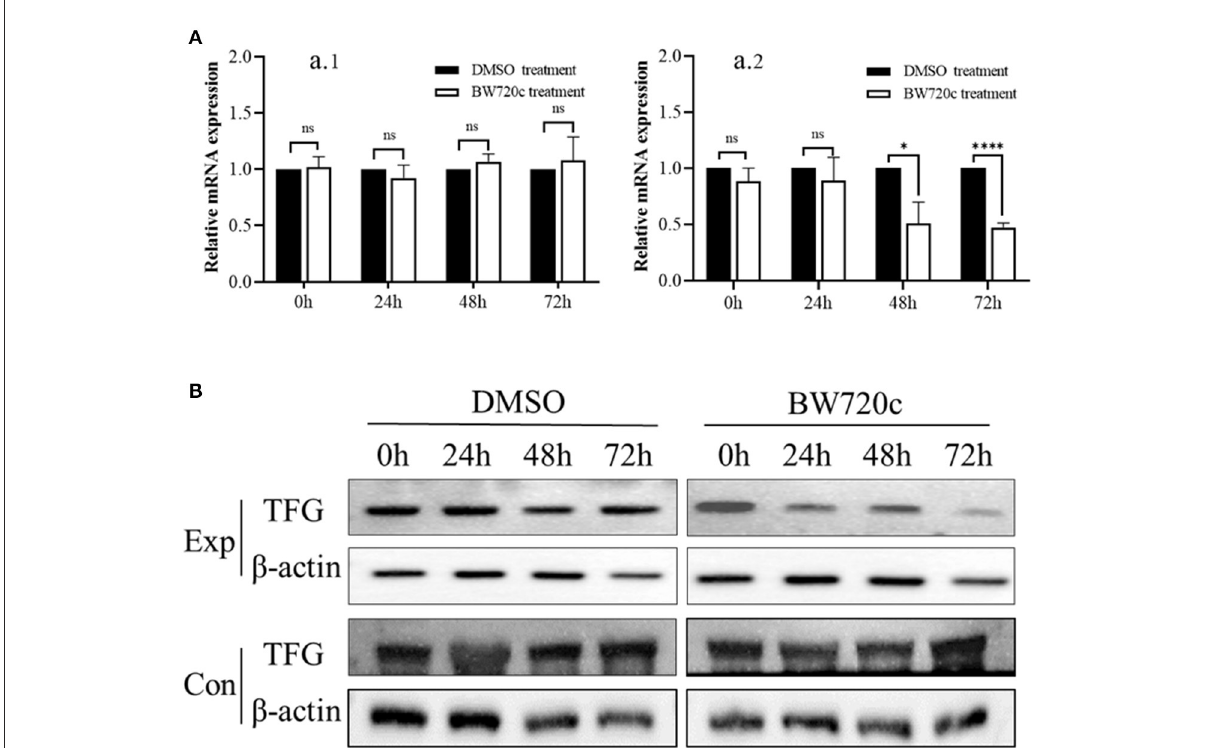
FIGURE5 Real-time PCR and Western blotting analysis of TFG (194) on T. annulata transformed cell and PBMCs. (A) Analysis of RT-qPCR of TFG (194) gene. (A) 1: Each bar represents the fold change of TFG (194) gene in treatment groups (BW720c) compared with control groups (DMSO) from PBMCs of uninfected bovine. (A) 2: Each bar represents the fold change of TFG (194) gene in treatment groups (BW720c) compared with control groups (DMSO) from T. annulata -transformed cells. The gene expression level was nomalized to GAPDH of bovine and the expression level of control groups was used as calibrator to calculate the fold change. Fold change was calculated based on a mean of three biological replicates. Asterisks indicate statistically significant differences between the treatment groups and the control, using Student’s t -test; ns, not significant ( p > 0.05), * p < 0.05 and **** p < 0.0001. Bars on top of the histograms indicate standard errors. (B) Western blotting analysis of TFG(194) protein. TFG (194) protein levels was detected in treatment groups (BW720c) and control groups (DMSO). Exp: T. annulata transformation cells. Con: PBMCs of uninfected bovine. Mouse anti β -actin monoclonal antibody was used as the loading